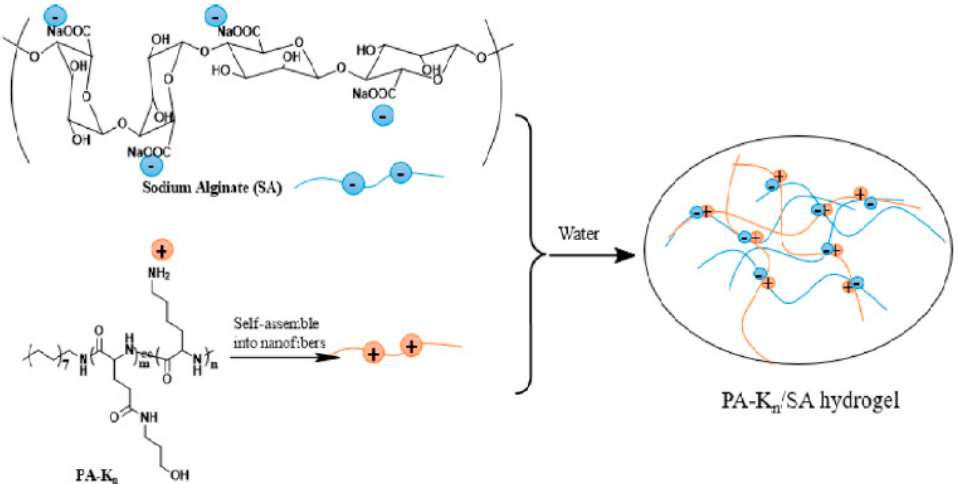
Figure 8. Cationic peptide amphiphiles-based supramolecular hydrogels with sodium alginate (n—the quantity of lysine unit in the peptide segment). Reprint with permission [127]; Copyright 2017, American Chemical Society.